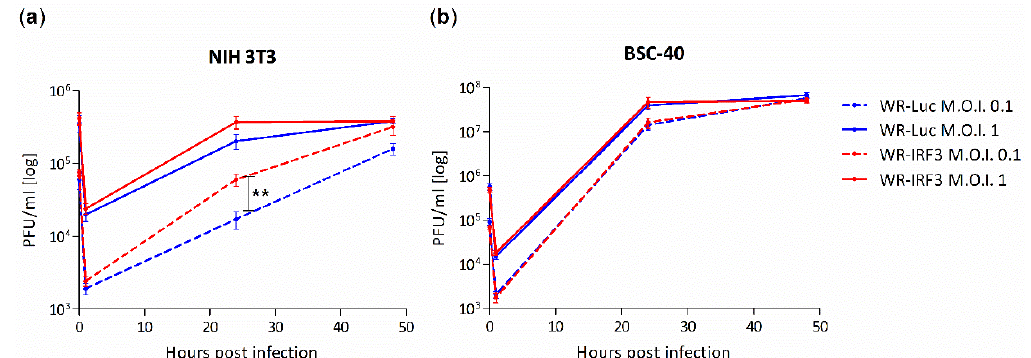
Figure 2. IRF-3 expressed by WR-IRF3 increases VACV growth in mouse cells. ( a ) NIH 3T3 and ( b ) BSC-40 cells were infected with WR-Luc or WR-IRF3 at M.O.I. of 0.1 and 1. At individual time points, the cells were collected and used for determination of virus titer. Graphs represent means of 3 independent experiments performed in duplicates +/- SEM. ** p < 0.01 (two-tailed unpaired Student’s t-test). WR-Luc, cells infected with VACV expressing luciferase; WR-IRF3, cells in- fected with VACV expressing Mu IRF-3.